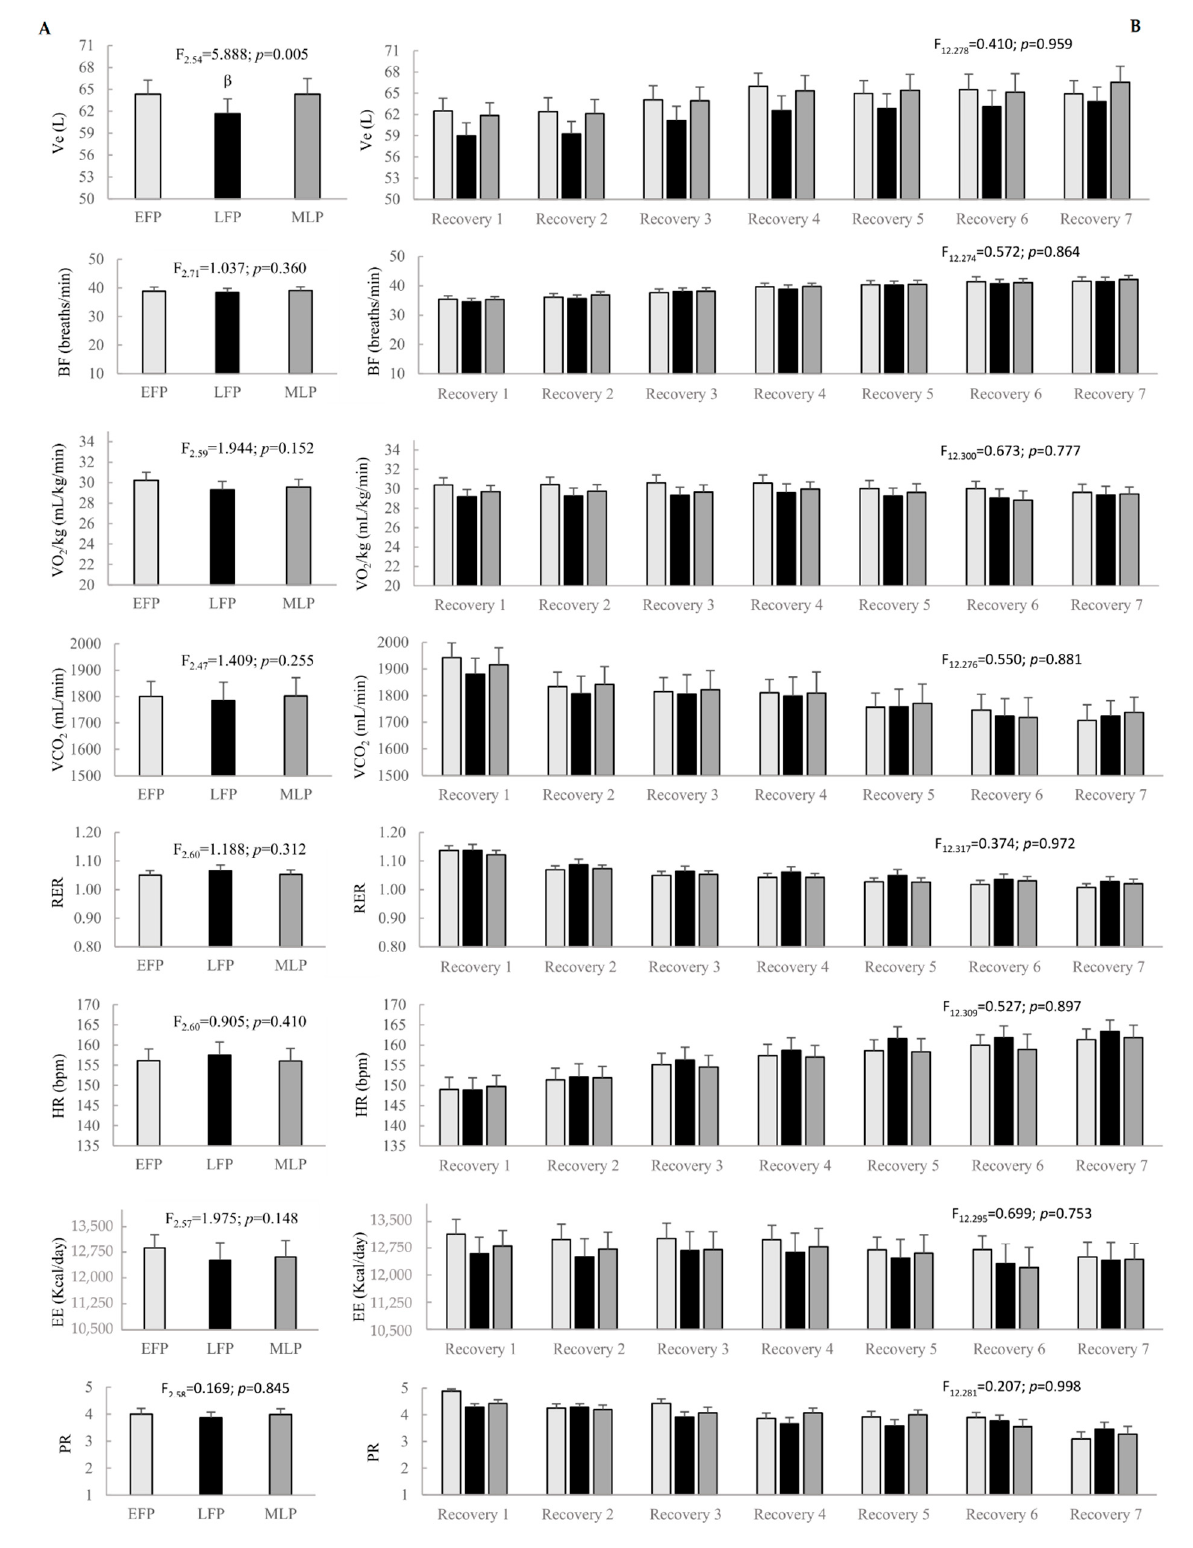
Figure 3. Menstrual cycle phase effect ( A ) and time* menstrual cycle phase interaction ( B ) on performance variables in the active recoveries throughout the interval running protocol. Ve: ventilation; BF: breathing frequency; VO 2 : oxygen consumption; VCO 2 : carbon dioxide production; RER: respiratory exchange ratio; HR: heart rate; EE: energy expenditure; PR: perceived readiness; EFP: early-follicular phase; LFP: late-follicular phase; MLP: mid-luteal phase. β Significant differences in LFP compared to EFP and MLP.